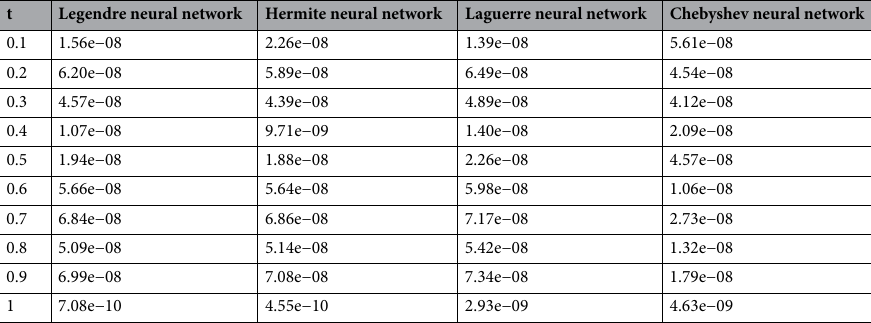
Table 1. The relative error for Example 6.1 with different orthogonal neural networks.